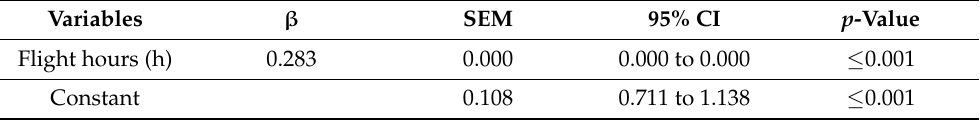
Table 8. Hearing loss adjusted by age in a multiple regression analysis.